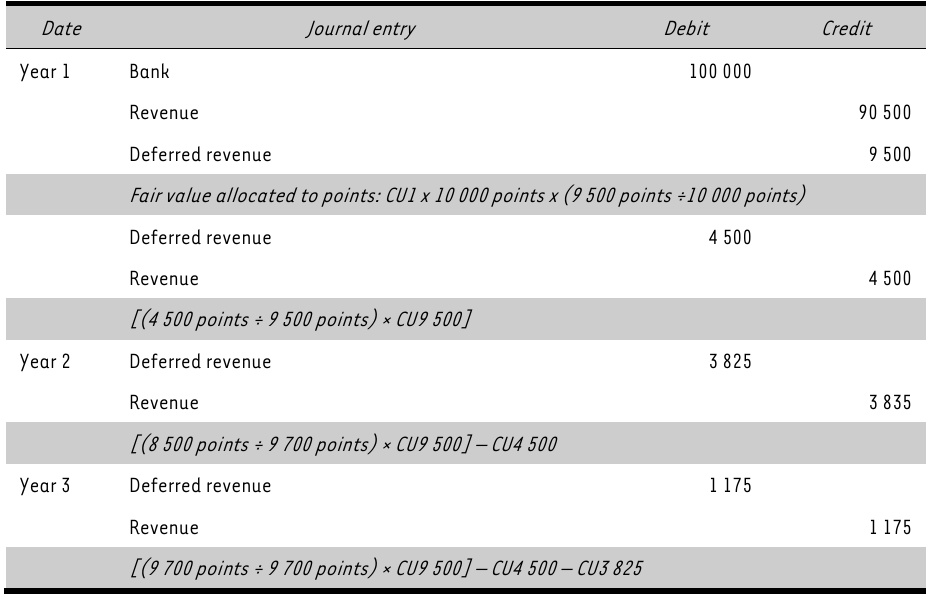
General journal entries of the client loyalty programme